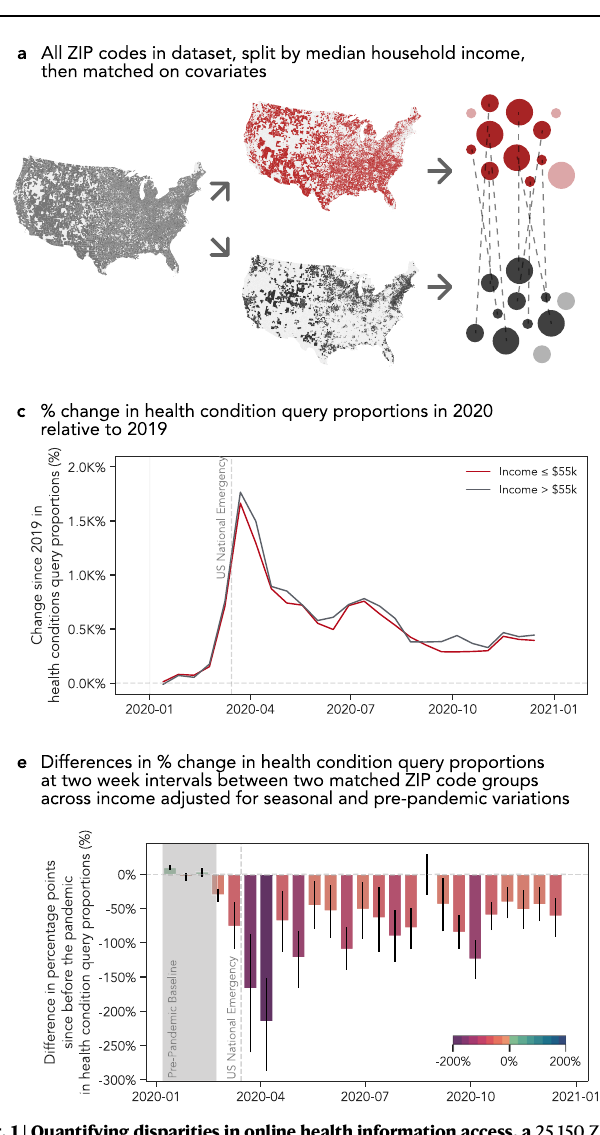
groups start to emerge. e We observe that low income ZIP codes experienced almost 200%less changeinhealth conditionqueries comparedto that ofthe high- income groups right after the US national emergency is declared ( n treated =12,555, n control =3854). f When the same matching-based comparisons are performed across all SDoH factors during the fi rst four weeks since the declaration of the pandemic in the US, ZIP code groups with lower incomes, higher proportions of Hispanic residents, higher population densities, and higher unemployment rates show signi fi cantly lower change proportions, while ZIP code groups with lower educational attainment show a signi fi cantly higher change in health condition query proportions (1603 ≤ n ≤ 12,575, Supplementary Table 6 for sample sizes per SDoHfactor).In e and f ,dataarepresented as meanvalues,anderrorbarsindicate 95% con fi dence intervals. Both mean values and con fi dence intervals are obtained through bootstrapping with 500